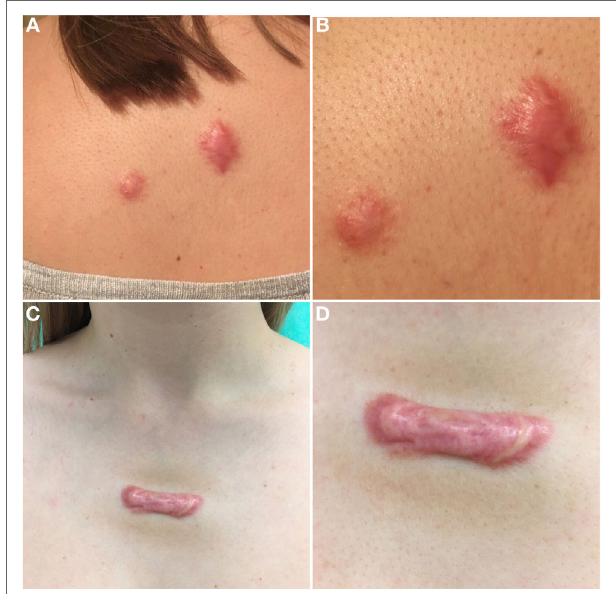
FiGURe 1 | Clinical appearance of hypertrophic scar (HS) and keloid. (A) HSs on upper back that developed after excision of dermal nevi. (B) Close-up of HSs. (C) Chest of patient showing keloid developed spontaneously. (D) Close-up of keloid.